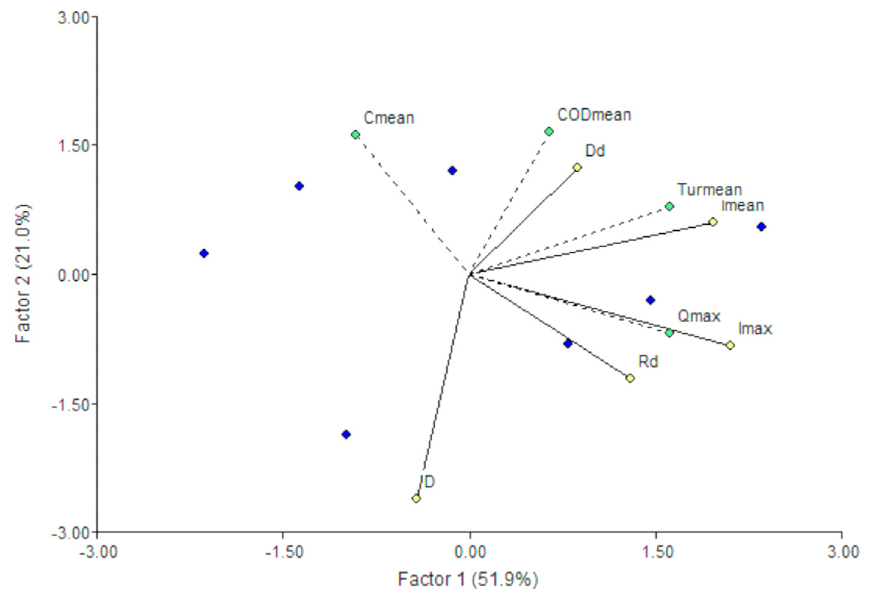
Figure 7. Triplot that represents the cases, the response variables and the predictor variables of the PLS model of the El Vado CSO in the same graph.